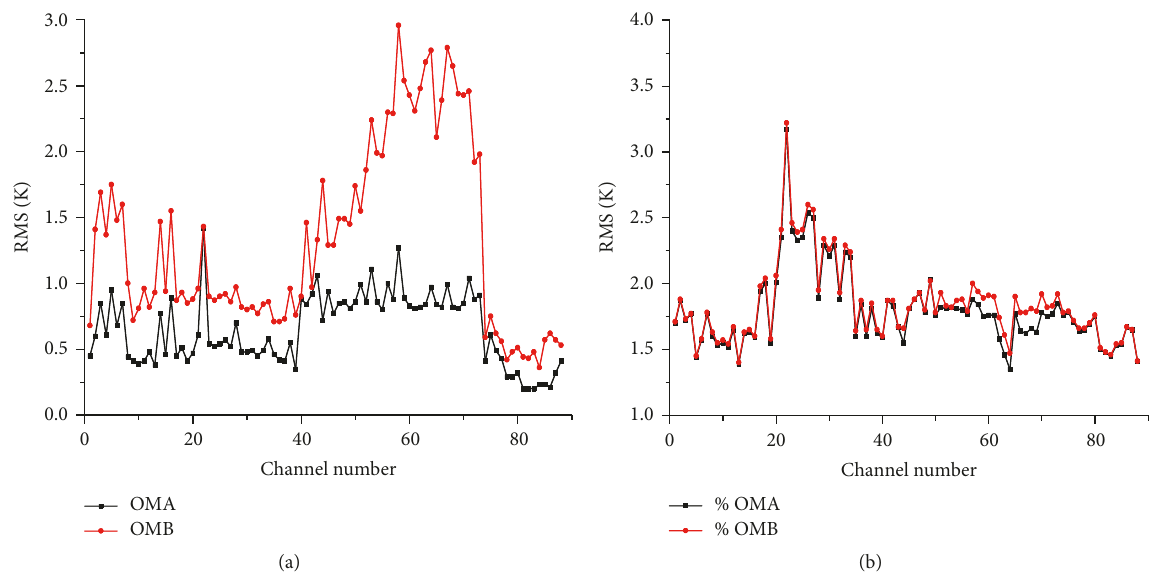
Figure 11: The RMS of OMA and OMB from each channel of the AIRS test and the AIRS_GRD